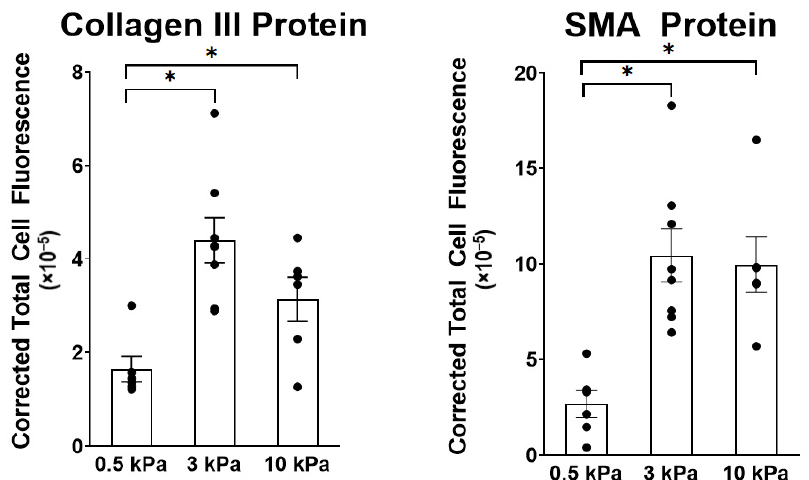
Figure 5. Effect of stiffness on protein expression of Collagen III and Smooth Muscle Actin (SMA) in PAAFs. Mean ± standard errors of the mean of Corrected Total Cell Fluorescence (CTCF) for 6–8 replicate hydrogels. * Significant pairwise effect of stiffness ( p < 0.05) determined by one-way analysis of variance (ANOVA).